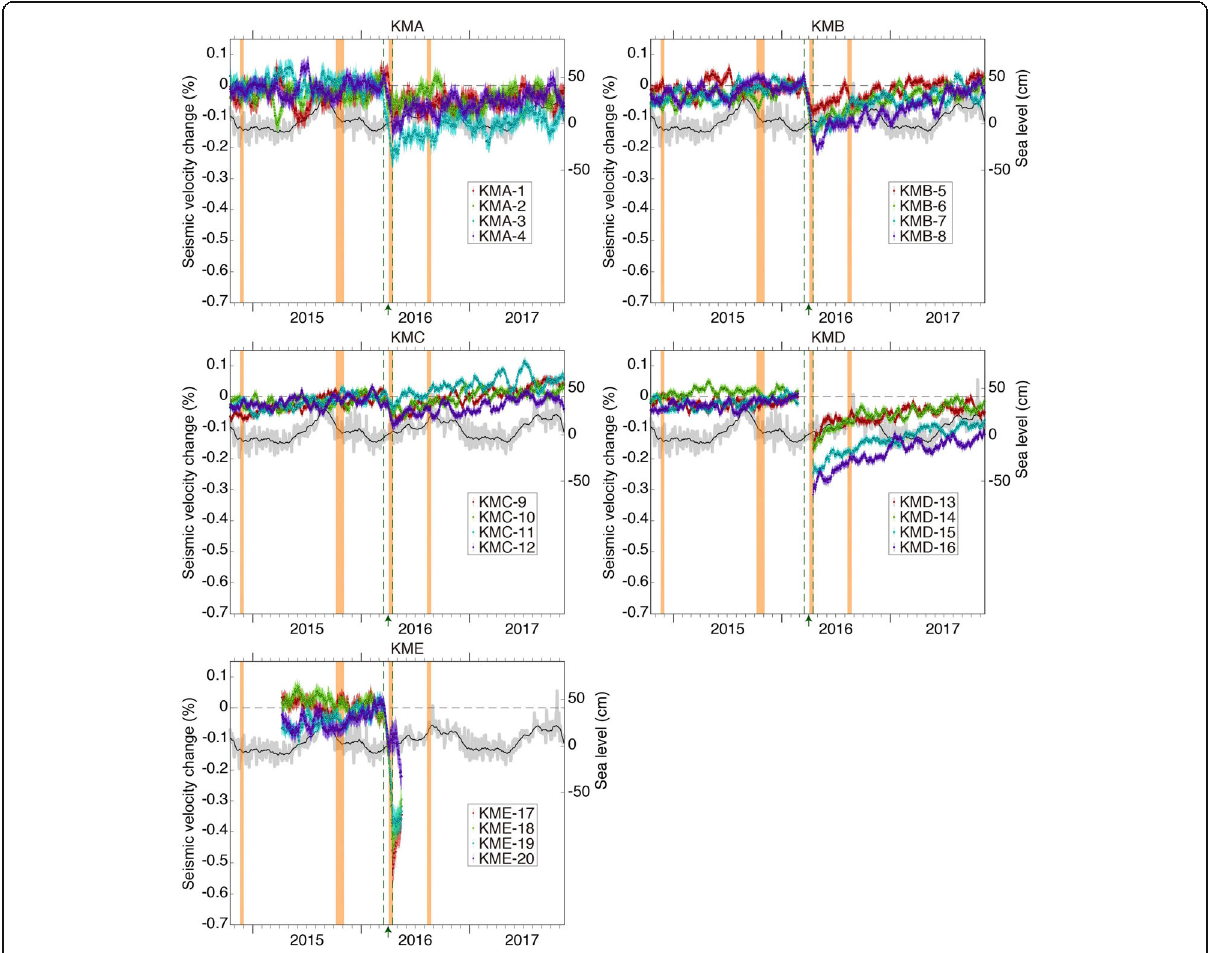
Fig. 5 Temporal variation of seismic velocity at each station (colored dots). Symbols are the same as in Fig.